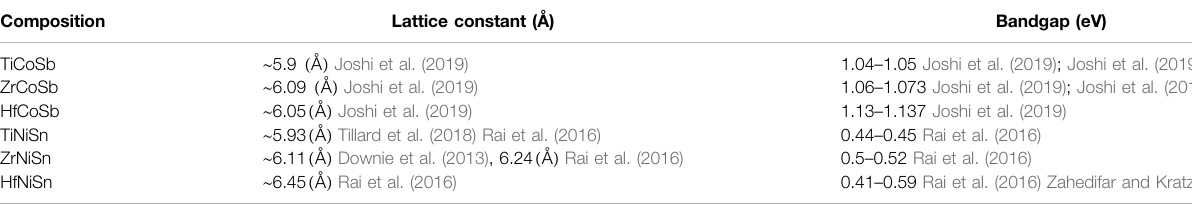
TABLE 1 | Lattice constants and bandgap values.